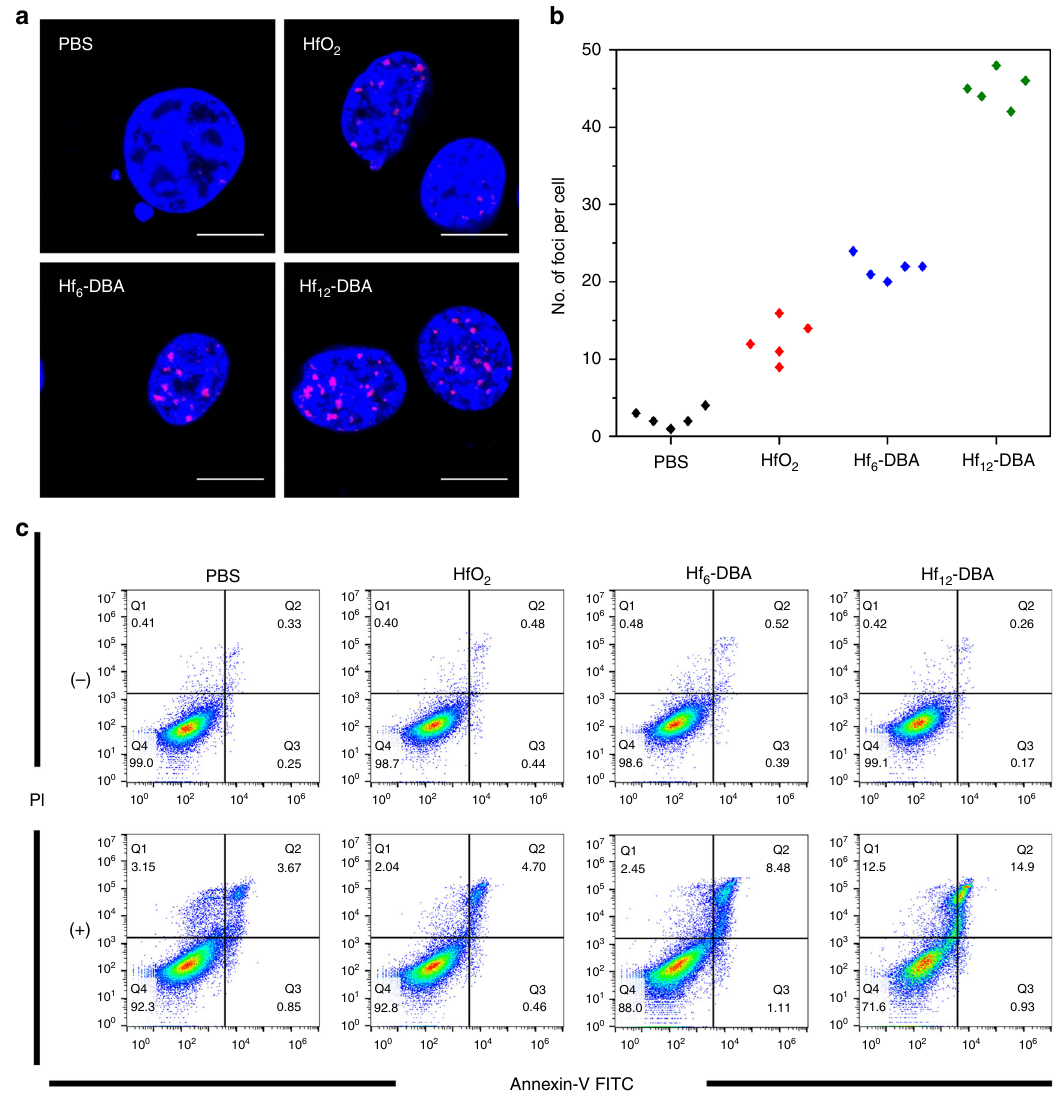
Fig. 3 In vitro mechanistic studies of nMOF-mediated RT cytotoxicity. a γ -H2AX assays showing the DSBs in CT26 cells treated with nMOFs and X-ray irradiation. Blue and red fl uorescences show DAPI-stained nucleus and antibody-labeled γ -H2AX in the cells, respectively. Scale bar = 10 µ m. b Quantitative analysis of number of DBS foci per nucleus. c Annexin V/PI analysis of CT26 cells. Cells were incubated with PBS, HfO 2 , Hf 6 -DBA, or Hf 12 - DBA with or without X-ray irradiation at a dose of 4 Gy. The quadrants from lower left to upper left (counter clockwise) represent healthy, early apoptotic, late apoptotic, and necrotic cells, respectively. The percentage of cells in each quadrant was shown on the graphs. ( + ) and ( − ) refer to with and without irradiation, respectively. Both confocal images and fl ow cytometry results were obtained with two repetitions. One of two repetitions with similar results is NP radioenhancers are not intrinsically cytotoxic and the low- dose X-ray showed negligible cytotoxicity without a NP radio- enhancer. Taken together, Hf 12 -DBA is a signi fi cantly more ef fi cient radioenhancer than both HfO 2 and Hf 6 -DBA at equivalent Hf and X-ray doses.